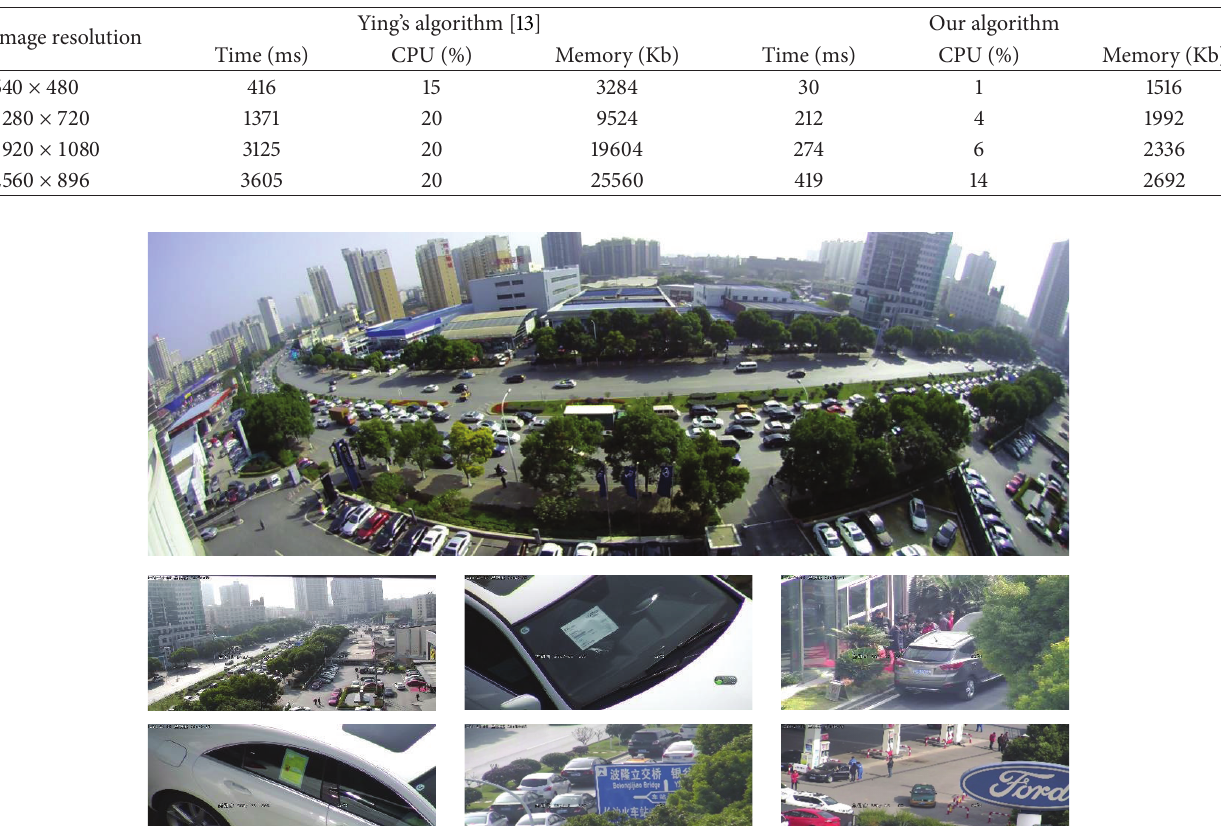
Table 1: Comparison of time and resource consumption.